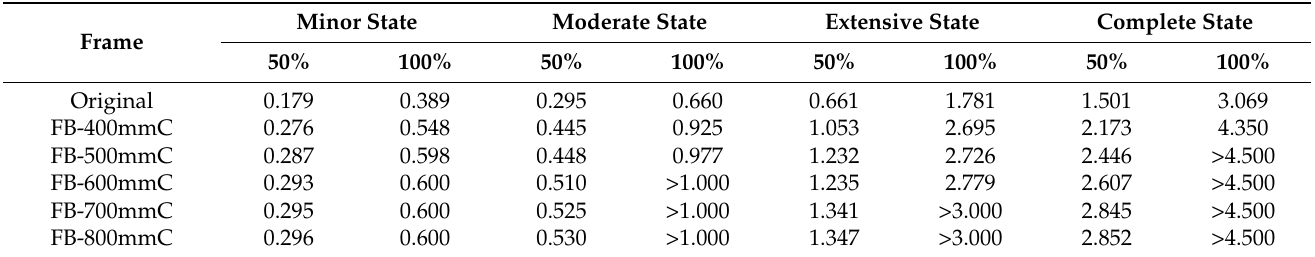
Table 9. The PGA (g)’s accordance with the probability of 50% and 100% of each state for FB-CFRP frames.